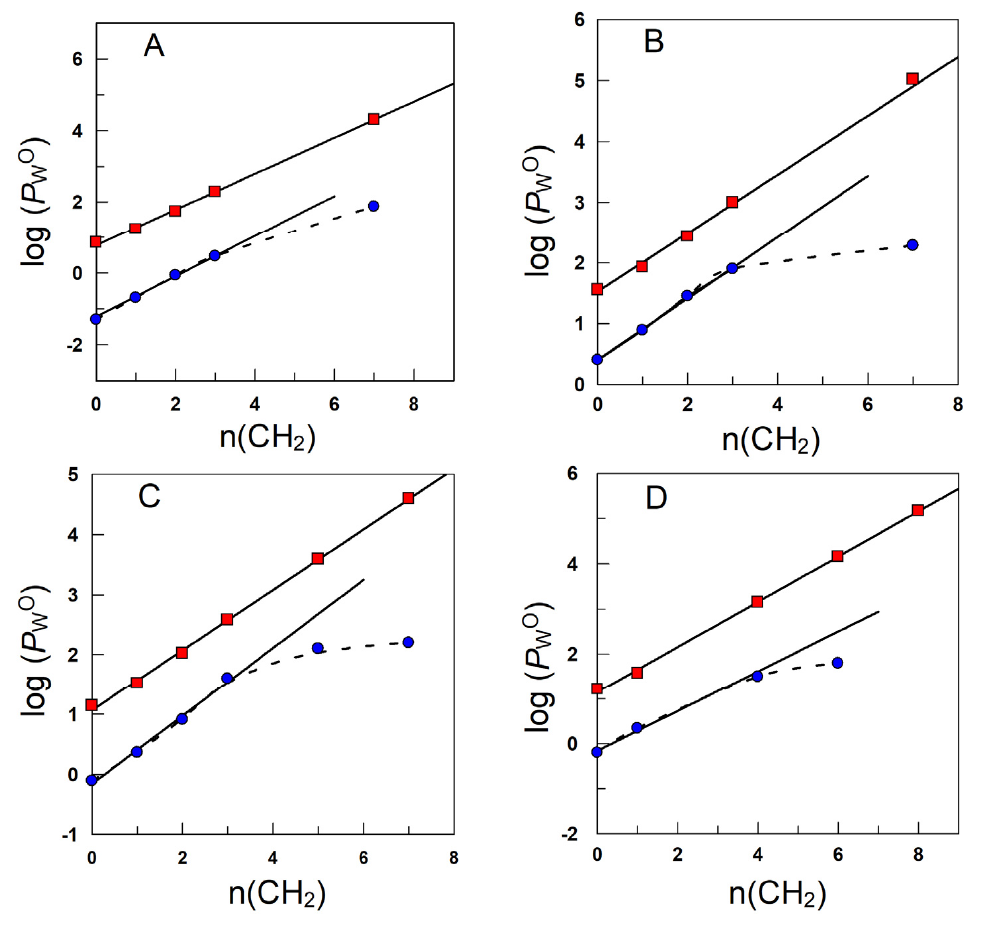
Figure 3. Changes in log( P WO ) with the number of methylene groups in the alkyl chain ( • ) of ester derivatives of gallic ( A ), ca ff eic ( B ), and protocatechuic ( C ) acids and hydroxytyrosol ( D ) in olive oil–water binary systems. P WO values are determined experimentally by employing the shake– flask method. For the sake of comparison, the partition coefficients of the same antioxidants in octanol–water systems ( P WOCT , (cid:4) ) are also displayed. P WOCT values are estimated by employing the Molinspiration (fragment-based) computer software [74] (see Table 2 for details). Figure adapted from Freiría et al. [67] with permission, copyright American Chemical Society. Table 5. Slopes and intercepts for the variations of log( P WO ) with the number of methylene groups according to Equation (5) (Figure 3) for ester derivatives of di ff erent antioxidants such as gallic acid (GA), ca ff eic acid (CA), protocatechuic acid (PT), and hydroxytyrosol (HT). Values from Freiría- Gándara et al. [67].